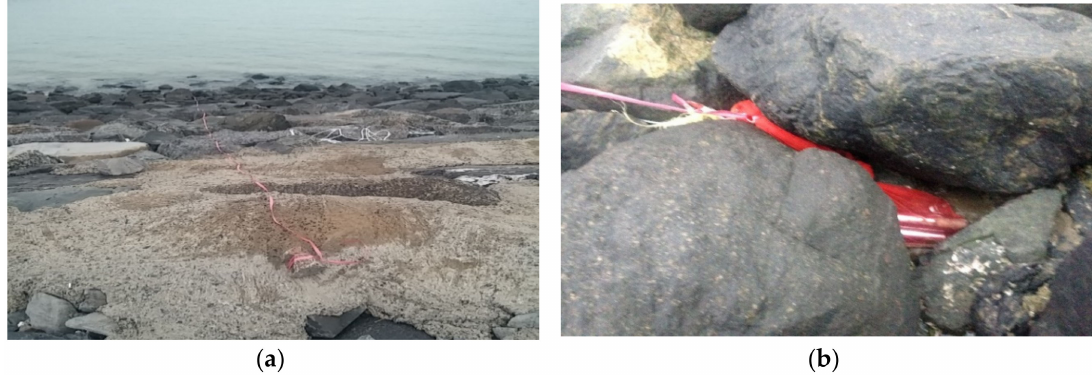
Figure 2. Sea water test of the materials for the cover of the FBG sensors: ( a ) during the tide; and ( b ) during the ebb tide.